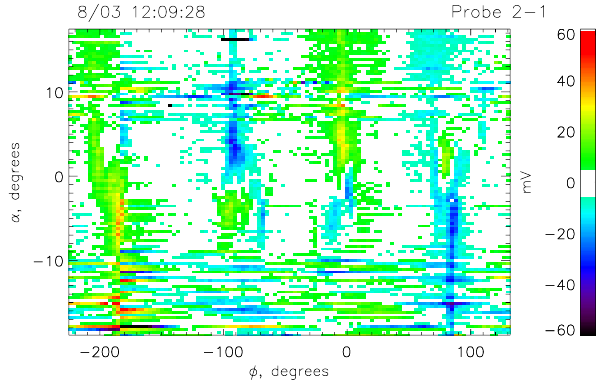
Fig. 17. (φ,α) map of disturbances in the EMMA probes po- tentials for Case 5. Potential disturbances related to the electric field changes on timescales below the spin period are seen as noise throughout the figure. Structured disturbances in probe potentials are evident when the probes are close to the magnetic field direc-